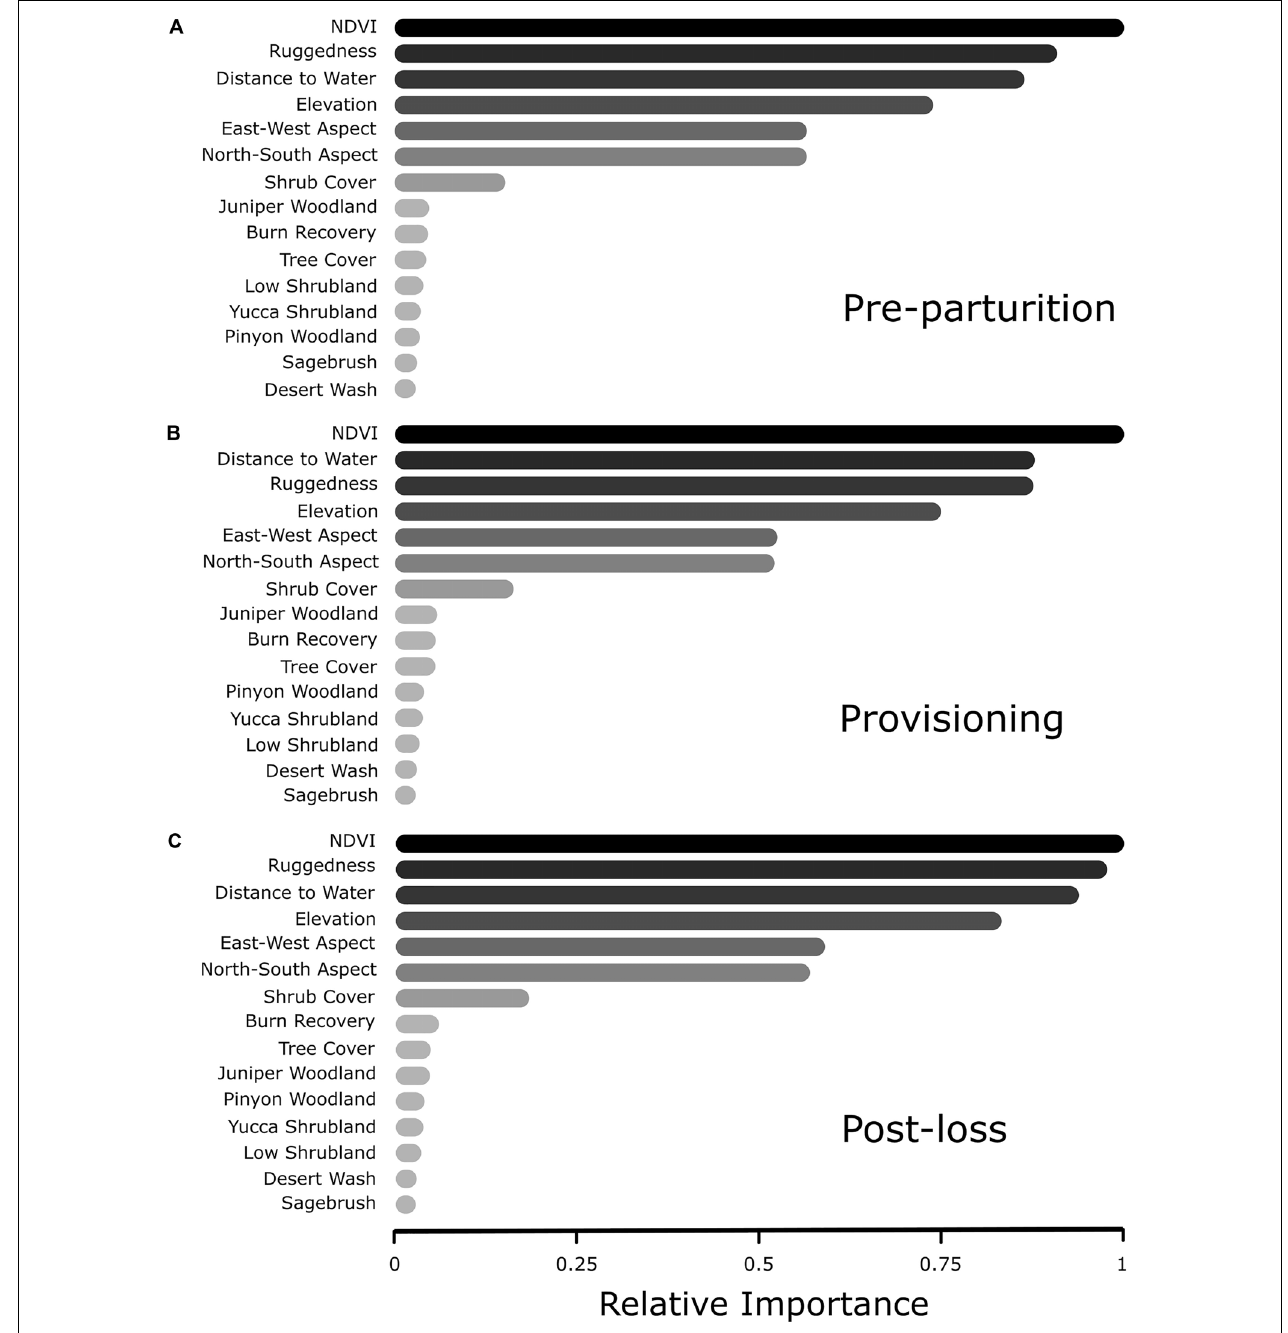
FIGURE 3 | Relative importance rankings of resource selection from random forest analysis of female mule deer during (A) pre-parturition ( n = 68), (B) while provisioning offspring ( n = 67), and (C) post-juvenile mortality ( n = 20) on the Mojave National Preserve, California, United States, 2013 – 2016. Relative importance illustrates the influence of the predictor on resource selection estimated through rigorous conditional inference trees via a random forest algorithm.